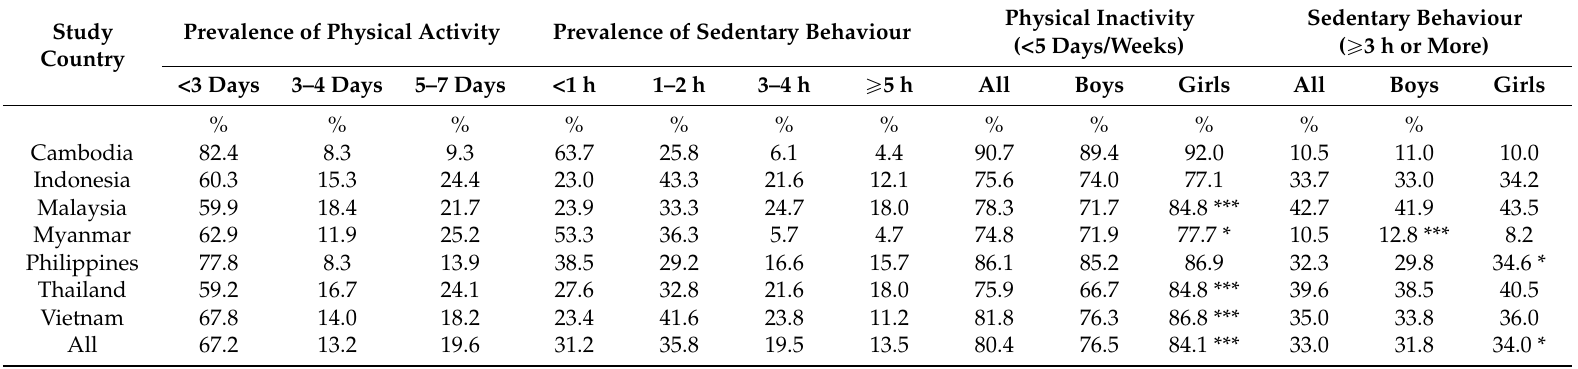
Table 3. Prevalence and duration of physical activity and sedentary behaviour among school-going adolescents in ASEAN.